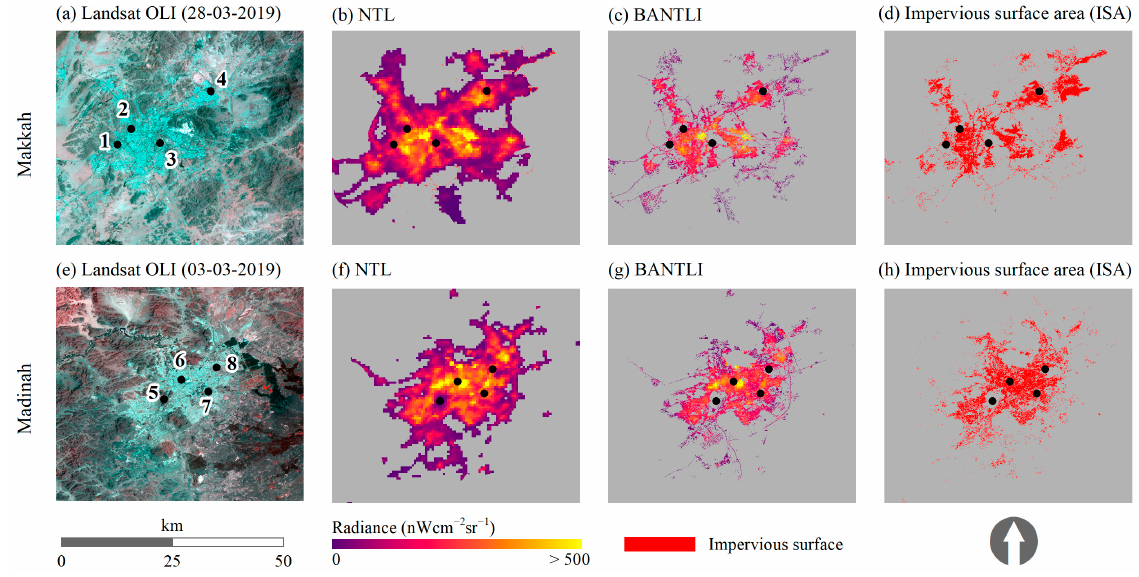
Figure 5. Spatial pattern comparisons of Landsat OLI, NTL (nWcm − 2 sr − 1 ), BANTLI (nWcm − 2 sr − 1 )